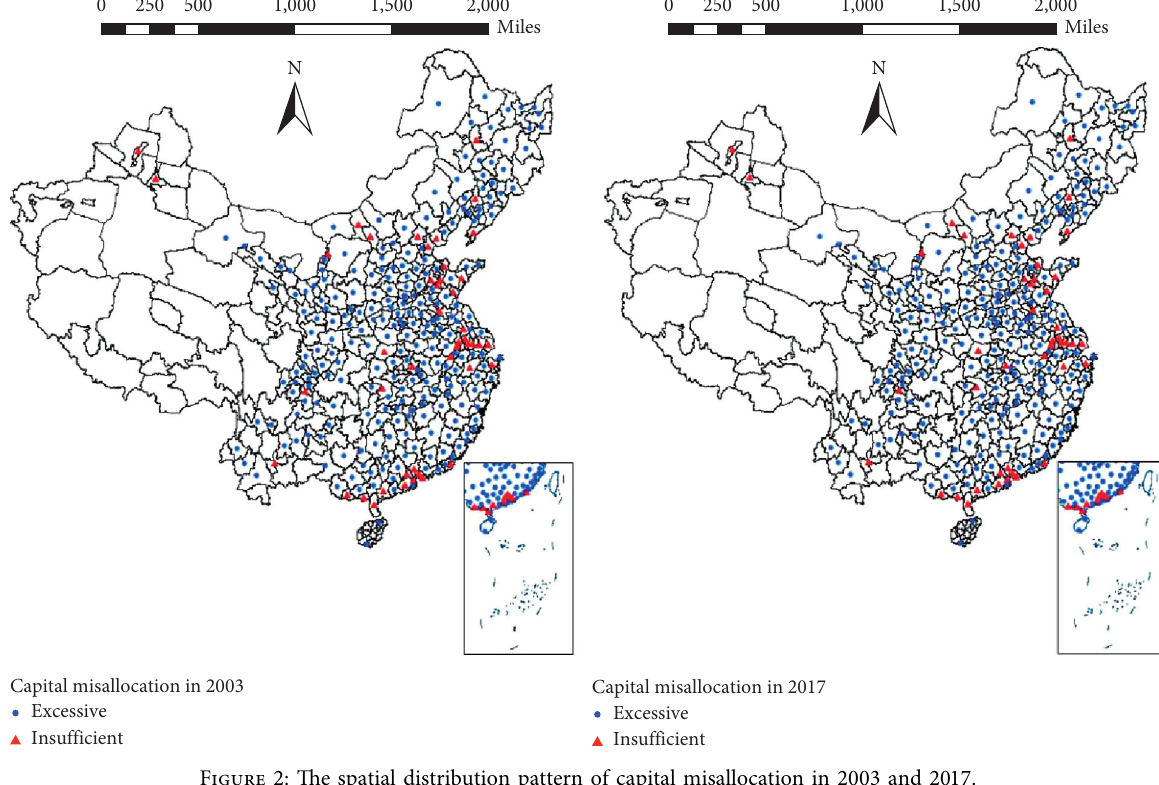
Figure 2: The spatial distribution pattern of capital misallocation in 2003 and 2017.